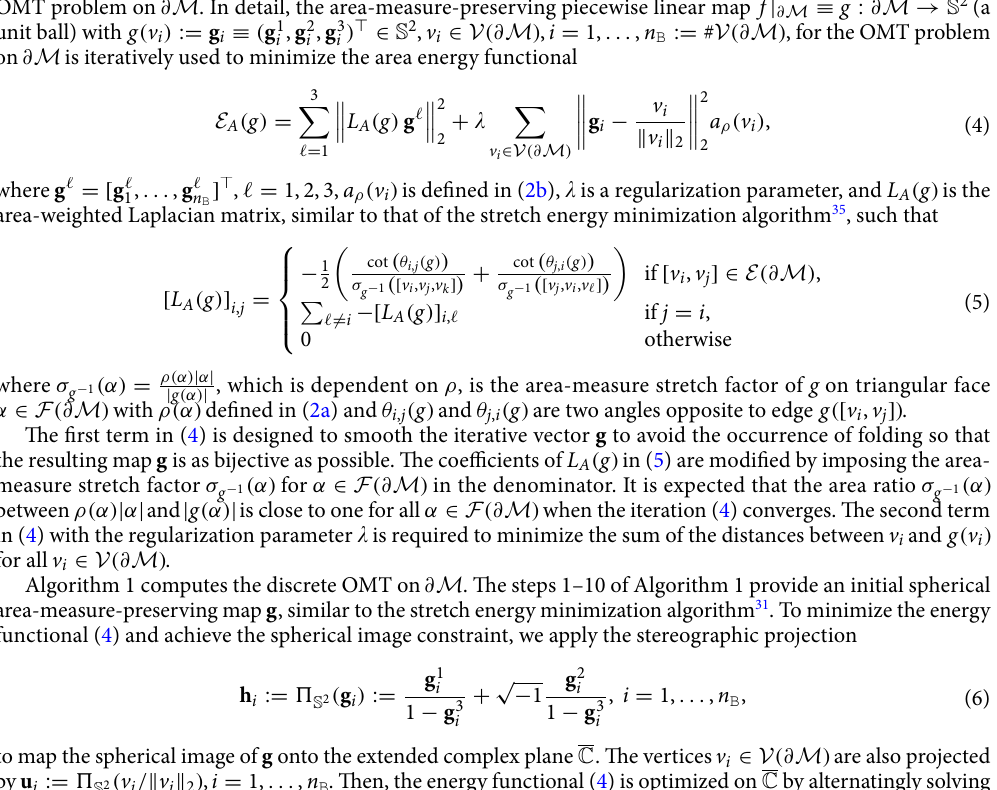
Algorithm 1 computes the discrete OMT on ∂ M . The steps 1–10 of Algorithm 1 provide an initial spherical area-measure-preserving map g , similar to the stretch energy minimization algorithm 31 . To minimize the